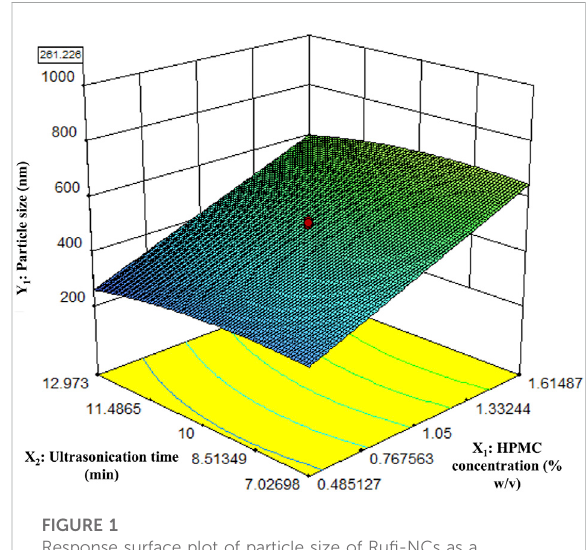
FIGURE 1 Response surface plot of particle size of Ru fi -NCs as a function of HPMC concentration and Ultrasonication